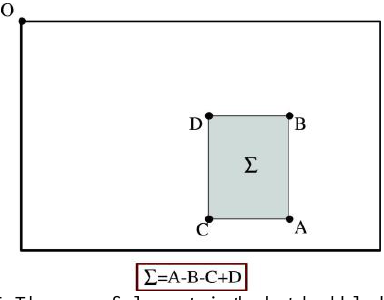
Figure 5. The sum of elements in the hatched block can be computed from one simple equation using the integral image (Bay et al.,